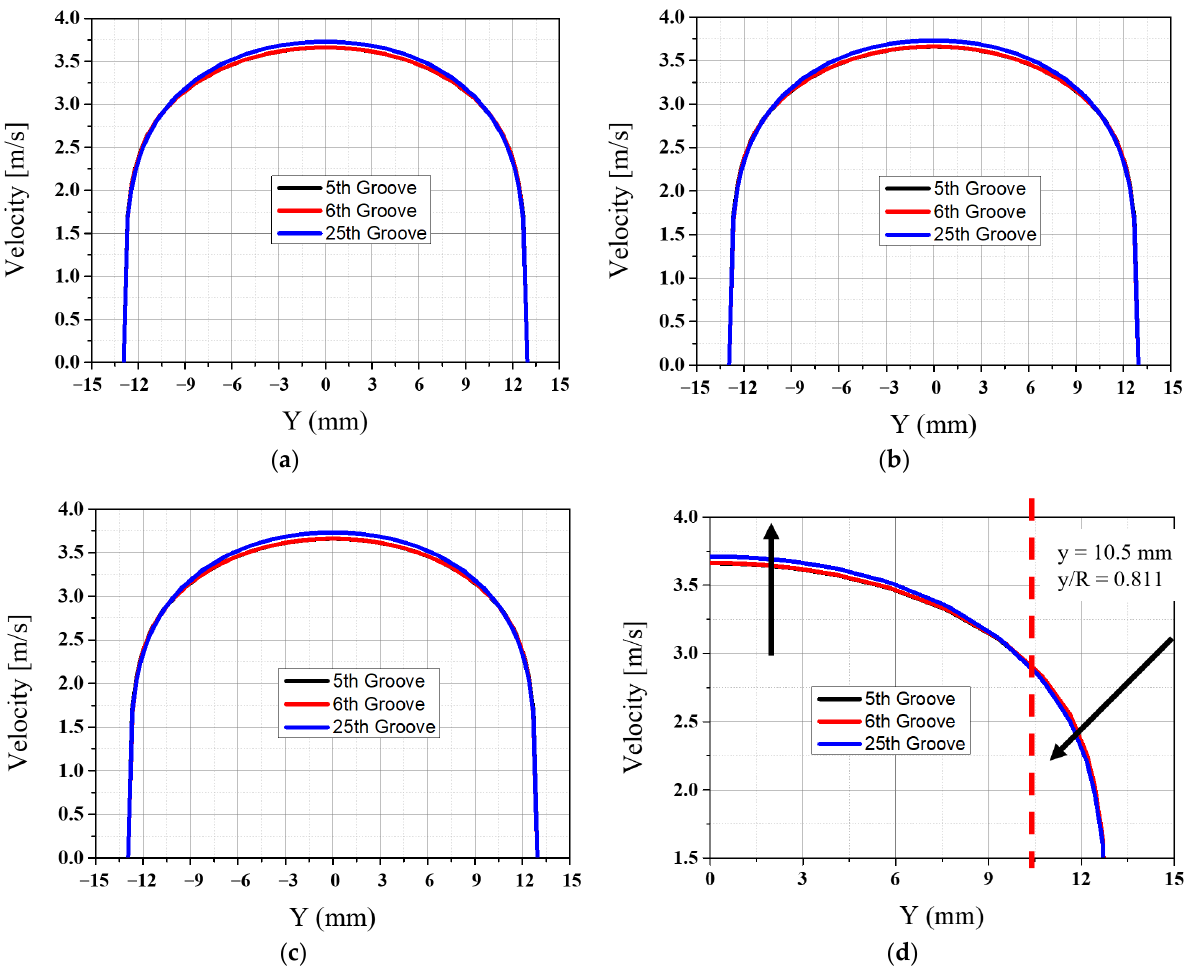
Figure 13. Main flow velocity distribution at groove end for different w / k : ( a ) Main flow velocity distribution at groove end for w / k = 0.5, ( b ) Main flow velocity distribution at groove end for w / k = 1.0, ( c ) Main flow velocity distribution at groove end for w / k =1.5, and ( d ) Velocity distribution of main flow in case of enlarged w / k = 1.5.